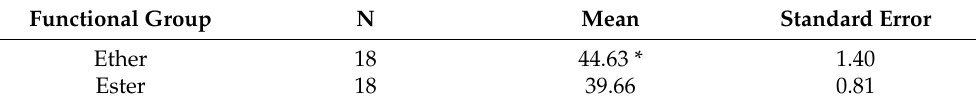
Table 3. Group statistics (FDI) (%) between functional groups of eugenol derivatives. Functional Group N Mean Standard Error